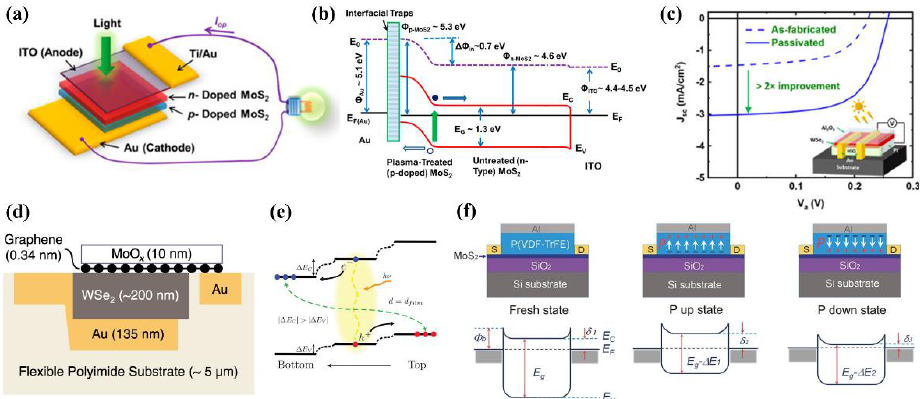
Figure 4. ( a ) Schematic of the plasma-treated MoS 2 solar cell. ( b ) Energy band level of the plasma-treated MoS 2 solar cell. ( c ) The performance improvement of the solar cell passivated by Al 2 O 3 under a 3400 K black body source of 30 mW/cm 2 . ( d ) Cross-sectional image of the MoO x /graphene/WSe 2 solar cell. ( e ) Energy band diagram of the strain-gradient WS 2 film. ( f ) The schematic and energy band diagram of the MoS 2 device under different polarization states. ( a , b ) Reprinted with permission from Ref. [127]. Copyright 2014, ACS. ( c ) Reprinted with permission from Ref. [129]. Copyright 2020, ACS. ( d ) Reprinted with permission from Ref. [130]. Copyright 2021, Springer Nature. ( f ) Reprinted with permission from Ref. [131]. Copyright 2015, WILEY. ( e ) Reprinted with permission from Ref. [132]. Copyright 2021, Wiley.